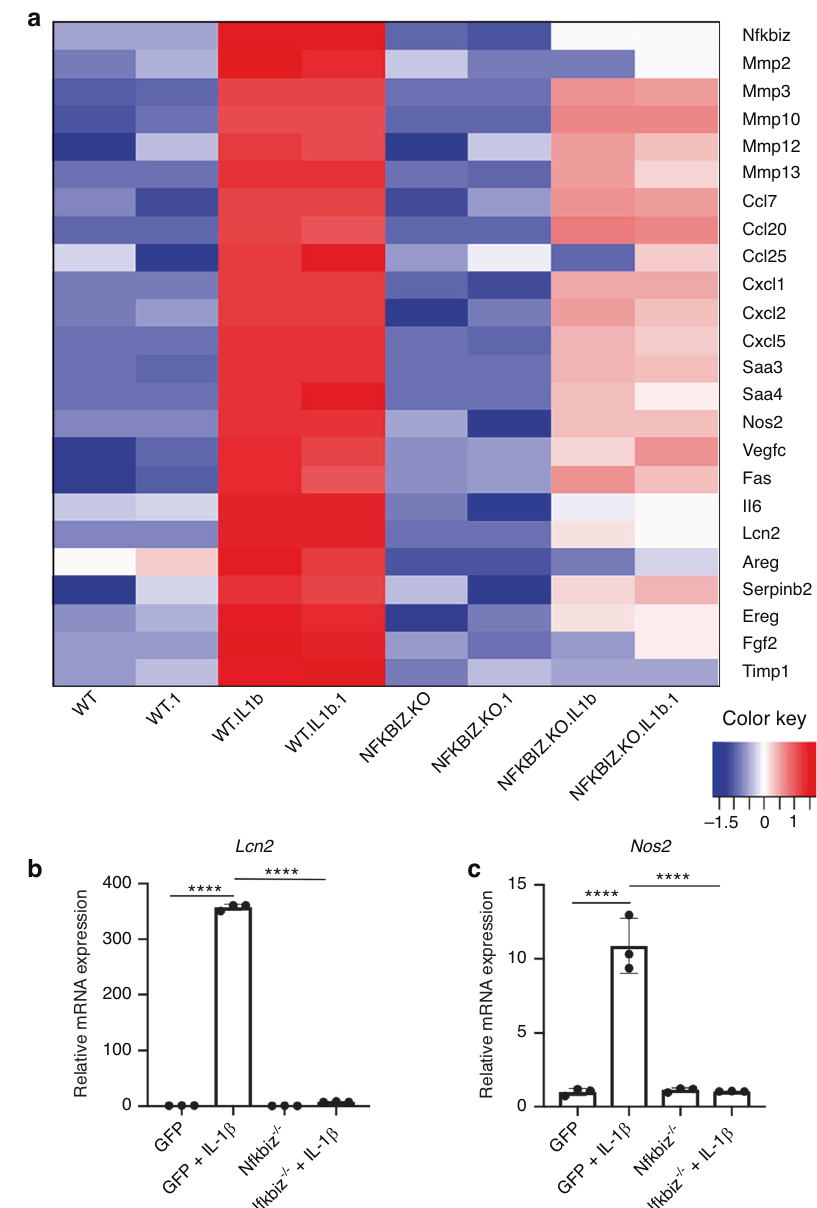
Fig. 6 I κ B- ζ is a major driver of SASP expression in chondrocytes subject to in fl ammation. a Wild type or Nfkbiz − / − chondrocytes were treated with IL-1 β (10 ng·mL − 1 ) for 24 h. RNA sequencing was performed and signi fi cantly downregulated SASP genes with Nfkbiz deletion are displayed. All samples were performed with biological duplicates. b , c Wild type or Nfkbiz − / − chondrocytes were exposed to IL-1 β (10 ng·mL − 1 ) for 24 h. Gene expression of Lcn2 and Nos2 was measured by qPCR. Bars are mean ± SD for three samples (**** P < 0.000